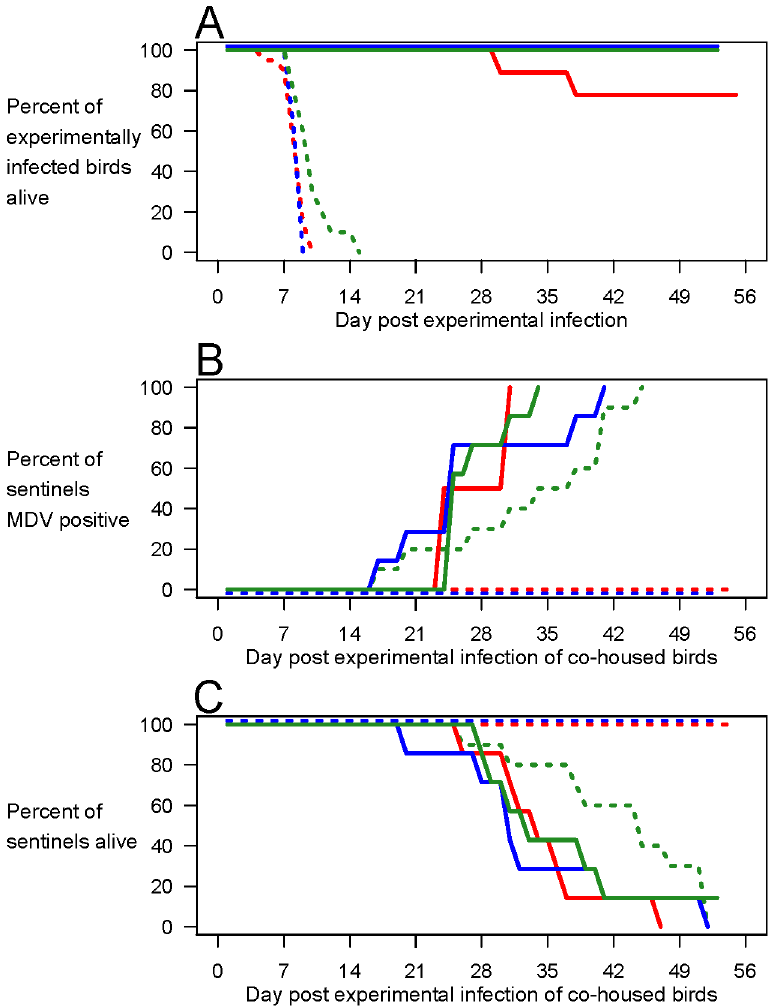
Fig 2. Vaccination enhances transmission of hyperpathogenic MDV. Experiment 2. Groups of ten birds were HVT-vaccinated (solid lines) or not (dotted lines) and experimentally infected with one of our three most virulent MDV strains, 595 (green), Md5 (blue) and 675A (red), and co-housed with ten unvaccinated sentinel birds. Vaccination prolonged the survival of experimentally infected birds ( A ), ensuring that sentinel birds became infected ( B ) and, hence, died ( C ). In B and C, solid lines denote sentinels cohoused with vaccinated experimentally infected birds and dotted lines denote sentinels cohoused with unvaccinated experimentally infected birds. Raw data can be found at